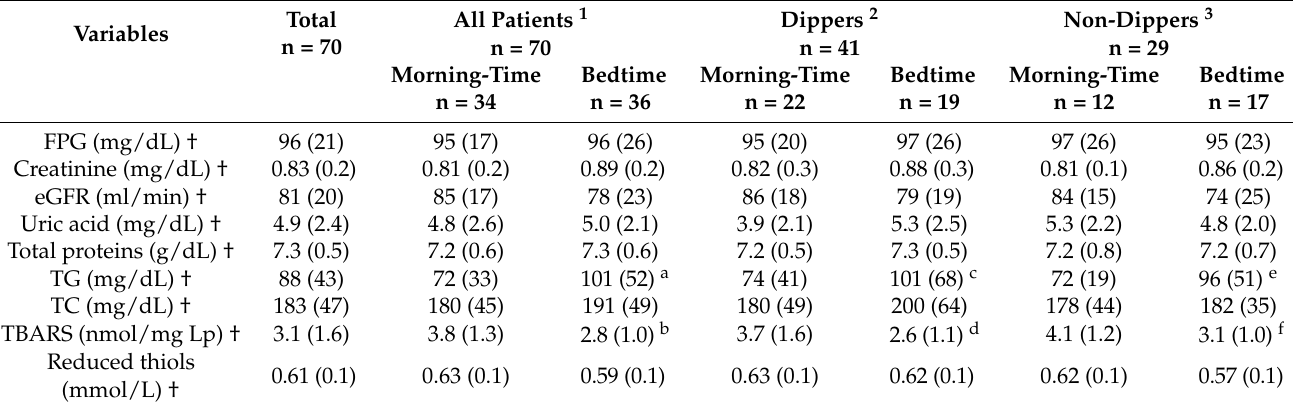
Table 3. Laboratory variables. Comparisons between morning and bedtime use of RAAS blockers in dipper and non-dipper hypertensive